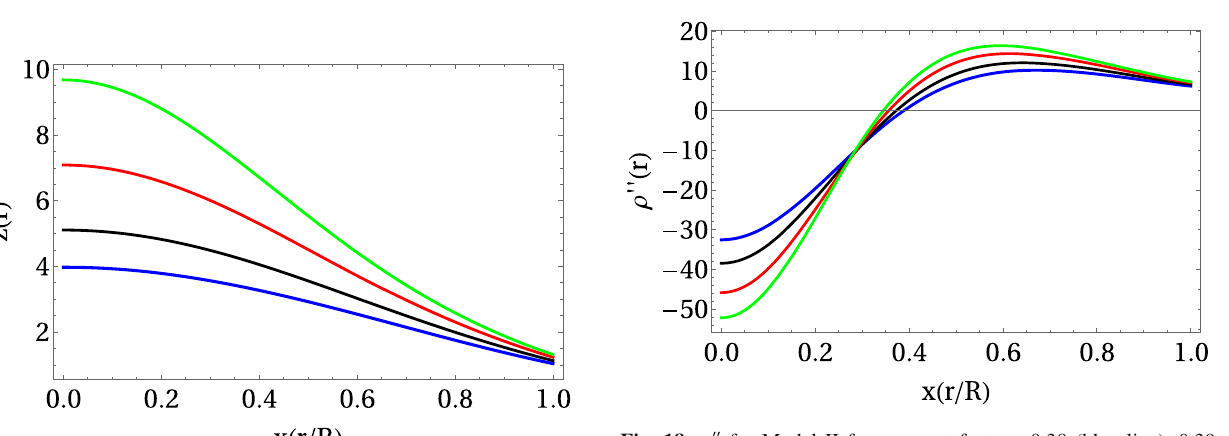
Fig. 18 ρ (cid:3)(cid:3) for Model II for compact factors: 0.38 (blue line), 0.39 (black line), 0.40 (red line) and 0.407 (green